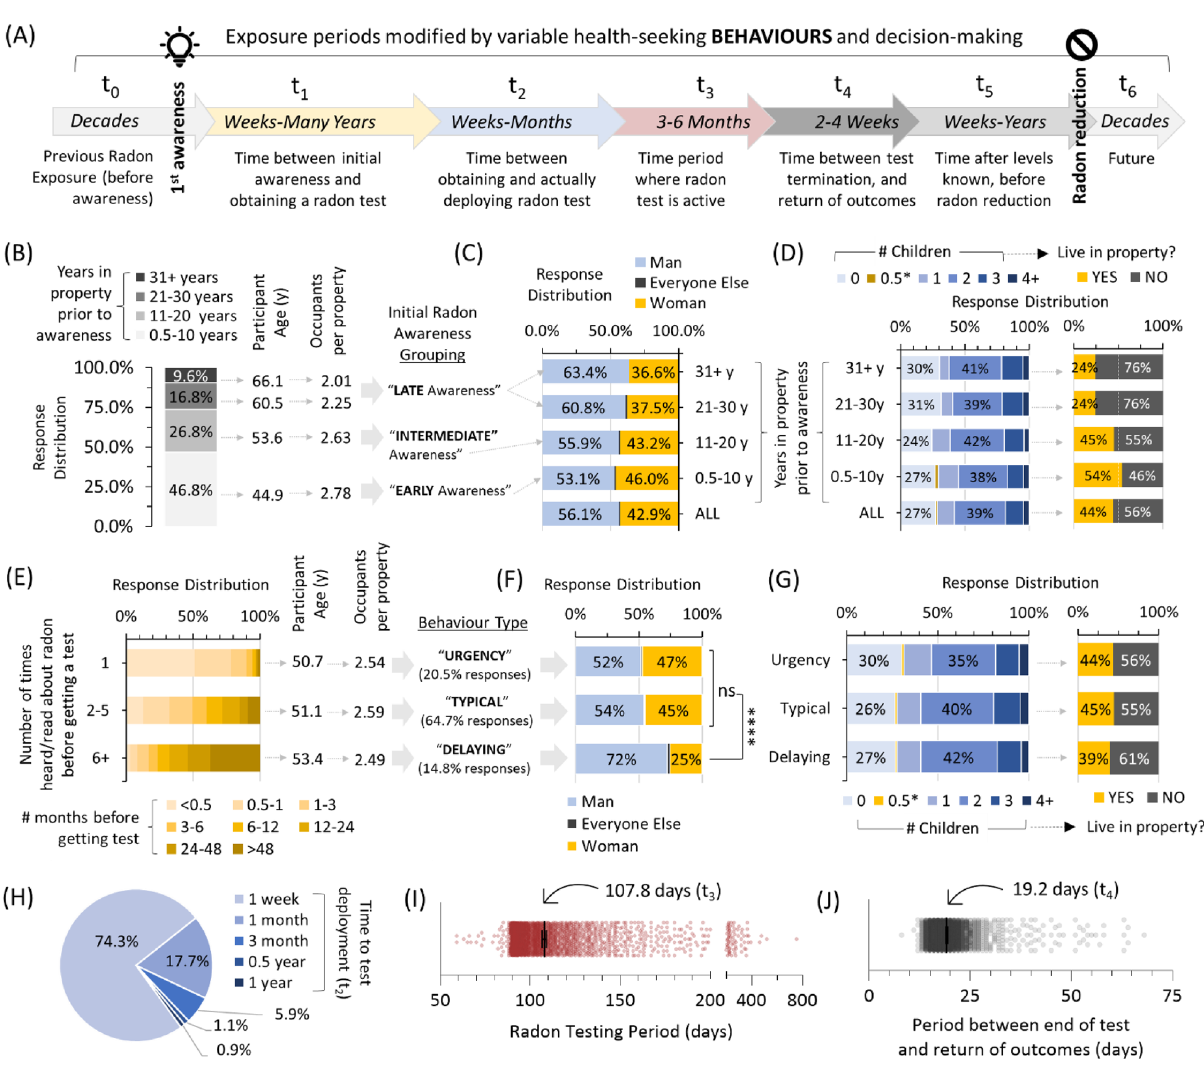
Figure 1. Residential radon exposure periods modified by radon awareness behaviour and test decision- making that can differ by age, sex/gender or parental status. ( A ) A schematic indicating seven variable time periods (t 0 to t 6 ) influencing human exposure to radon gas in residential properties. ( B ) The period from first moving into a primary residence to initial radon awareness (t 0 ) separated into early, intermediate and late awareness groups, with geometric mean age and occupants per property. ( C,D ) Sex/gender distributions, total number of children, children living in property at time of radon testing, for the groups outlined in ( B ). 0.5* indicates households with pregnant occupants. ( E ) The period from initial radon awareness to obtaining a radon test (t 1 ) separated into urgent, typical and delaying behavioral groups, with geometric mean age and occupants per property. ( F,G ) Sex/gender distributions, total number of children, children living in property at time of radon testing, for the groups outlined in ( E ). 0.5* indicates households with pregnant occupants. Statistical comparisons are 1-way ANOVA. ****p < 0.0001; ns = p > 0.05. ( H ) Distribution of periods from obtaining to deploying a radon test (t 2 ). ( I ) Individual radon testing periods (t 3 ) with geometric mean. ( J ) Individual radon test return to outcome periods (t 4 ) with geometric mean. Figures were prepared using Excel and GraphPad Prism 9.1.1 (225) (www. graph pad.